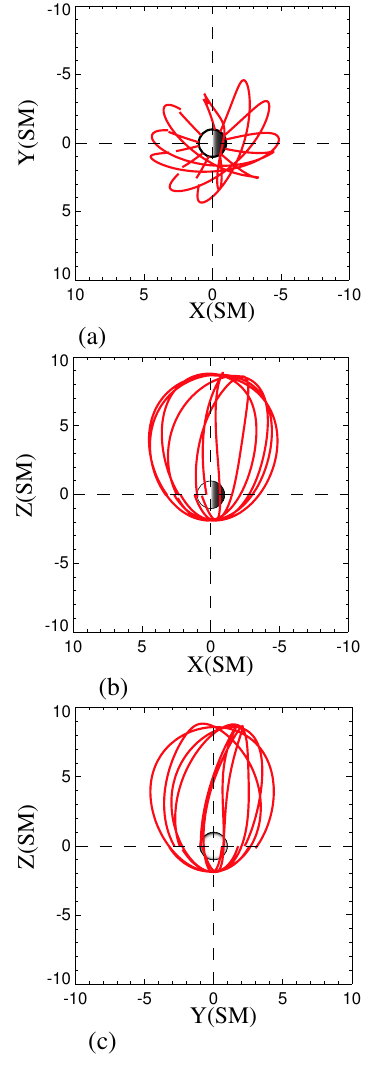
Figure 1. Fig. 1. Six single orbits of the Polar spacecraft, each separated by one month from February 1997 to July 1997 in solar magnetic (SM) co-ordinates. Figure ( a ) indicates the precession of the orbit as viewed in the X–Y plane (i.e. looking down on the polar cap) and shows how the spacecraft can cover all MLTs. Figures ( b ) and ( c ) indicate how the orbit precesses in 6 months in the X–Z and Y–Z plane, respectively. sketch of an IDF with a positive gradient region is presented in Fig. 2. Each ∂ f i data point in the positive gradient region (marked in green on Fig. 2) was then transformed back from velocity space to real space, using Eq. (5), to determine the average number density of particles, ∂n i , at that particular energy. It was then assumed that all particles with free energy (i.e. in the positive gradient region) would return to some predefined minimum, ( W min , f min ) which is set by the location of the initial point of the positive gradient region in each particle distribution (marked point A on Fig.